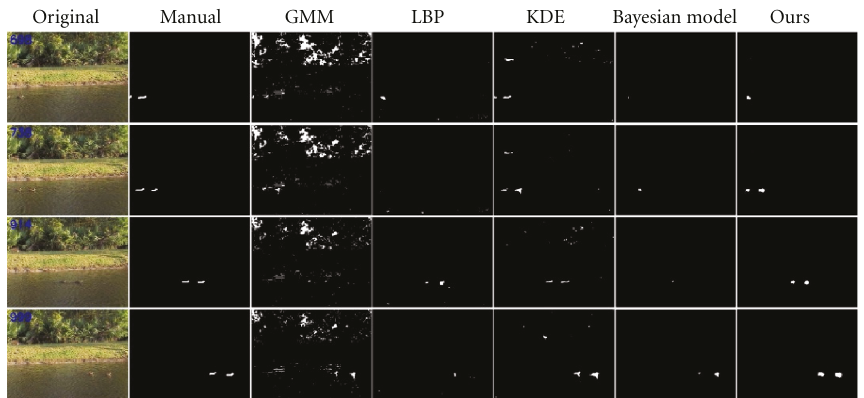
Figure 5: Qualitative comparison results of the five BGS algorithms on the Ducks sequence. The first column contains the original video frames. The second column contains the corresponding ground truth frames. The last five columns contain the detection results of the GMM, LBP, KDE, Bayesian Model and our method, respectively.